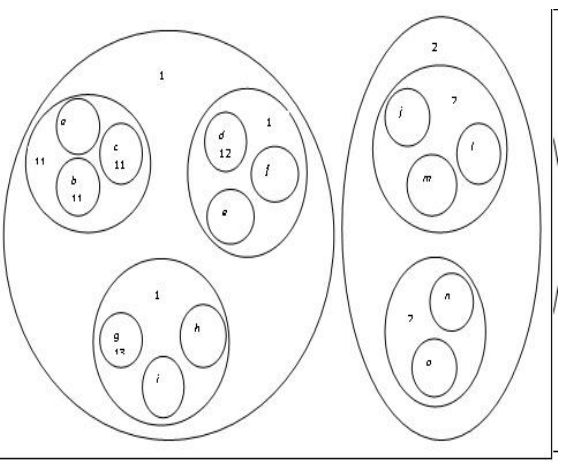
Figure 2. DST with nodes, names and IP